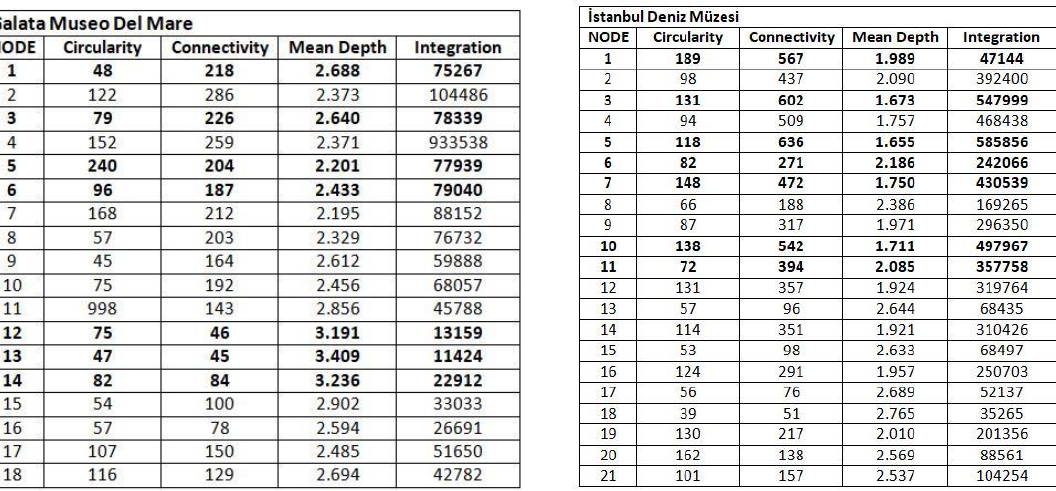
isovist fields are indicated in Table 2-3) .